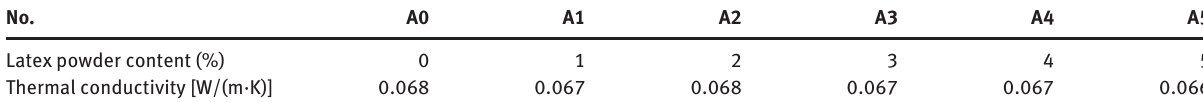
Table 2 Effect of different contents of latex powder on the thermal conductivity of the